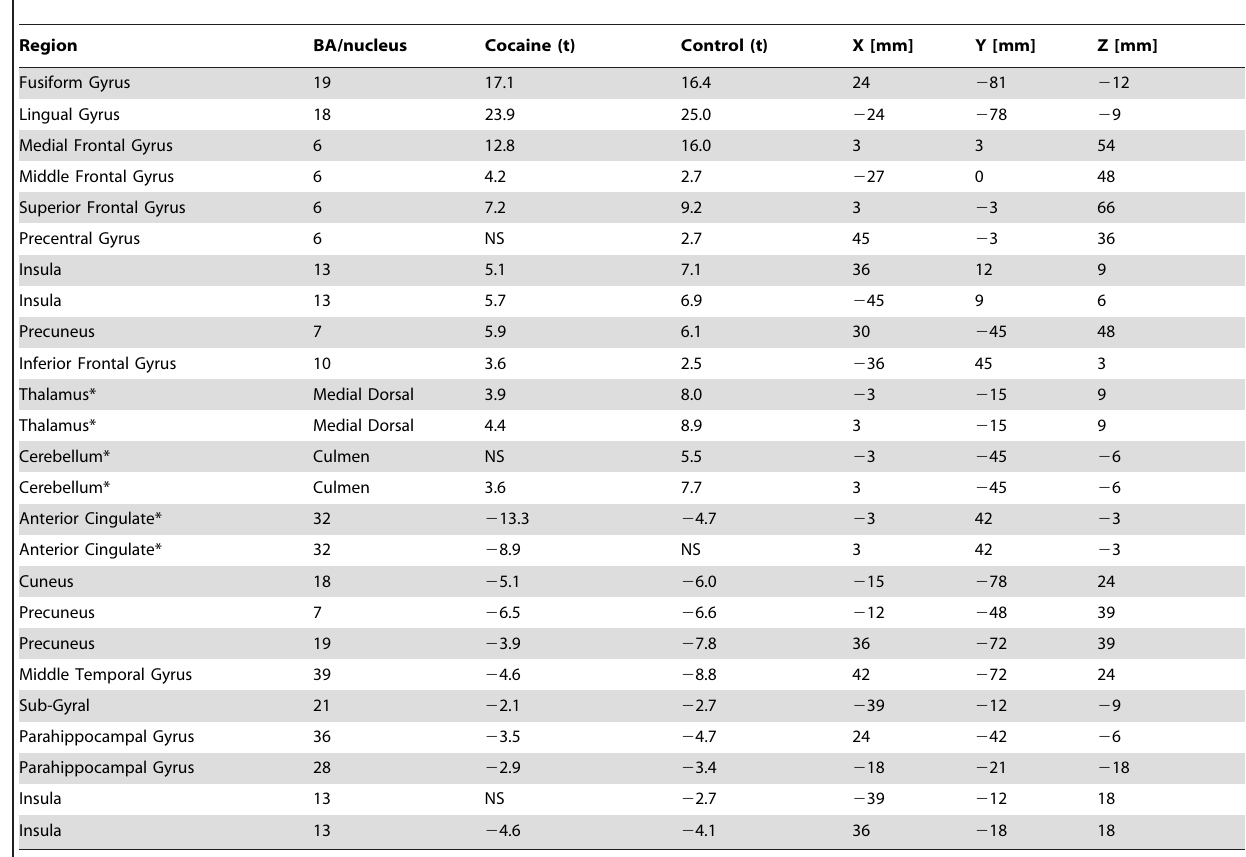
Table 2. Statistical significance (t-score) of brain activation during the DW paradigm for cocaine and control subjects and their location in the Talairach frame of reference (x, y,